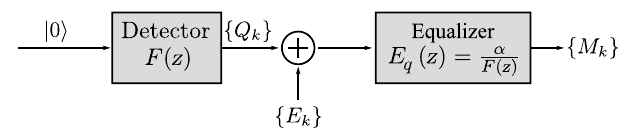
FIG. 4. The block diagram for a zero-forcing linear equalizer [29]. | 0 (cid:2) represents the input shot noise, Q k represents the shot noise sampled after passing through the detector at time k , E k represents the excess noise, and M k represents the outcome of the homodyne